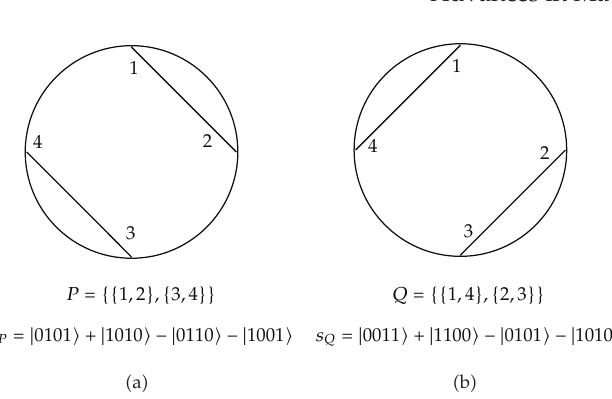
Figure 1: The two non-intersecting 4-qubit chord diagrams and their associated singlet product